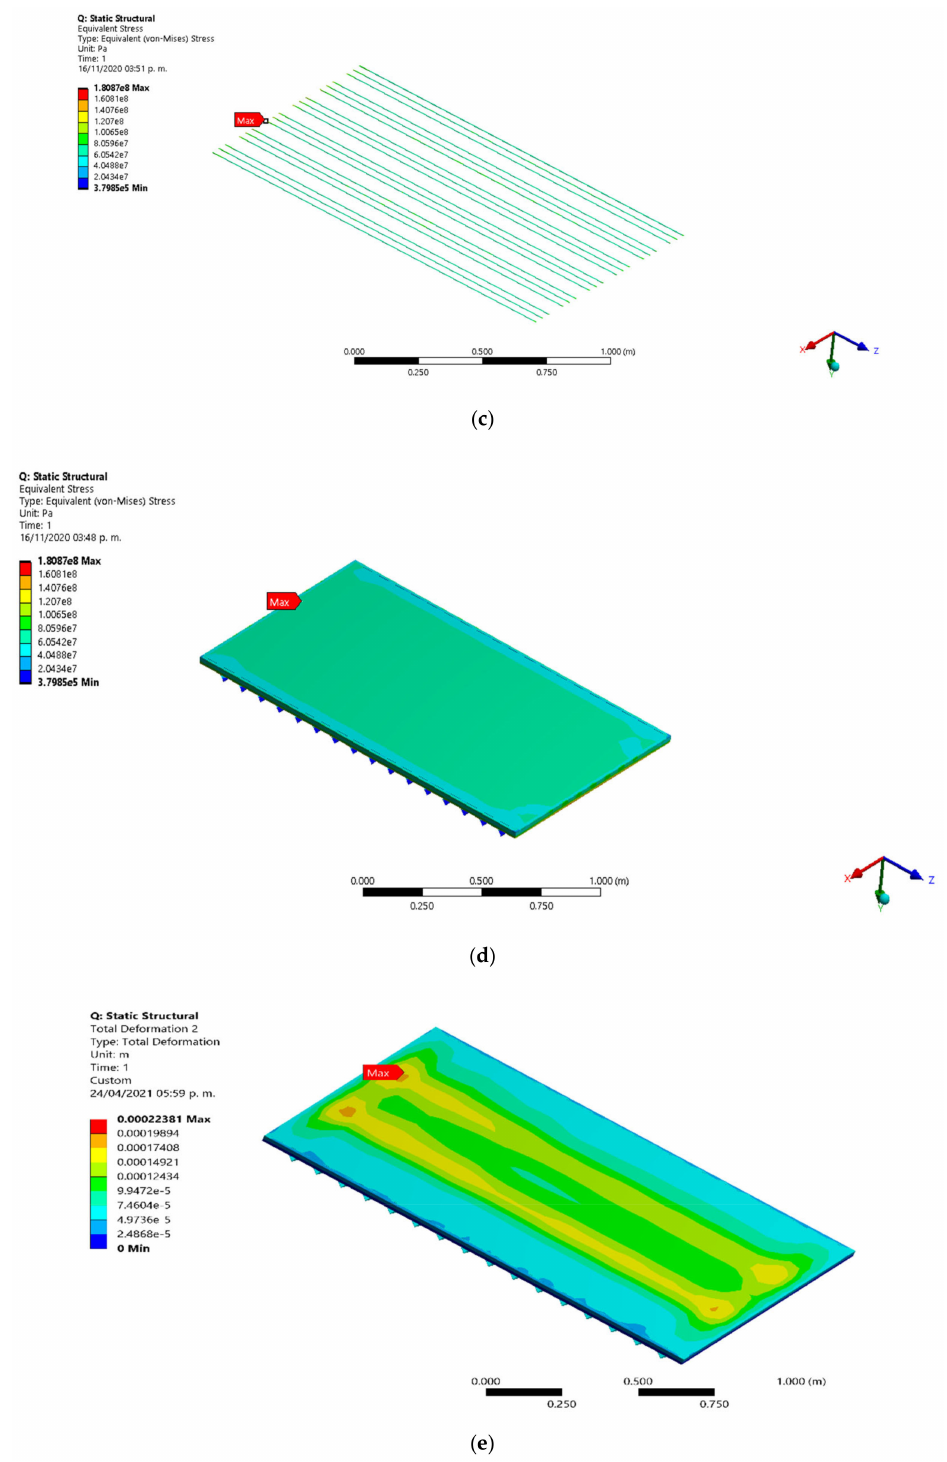
Figure 8. Maximum and minimum stress fields. ( a ) Stress distribution of the whole panel. ( b ) Stress distribution at the electric contact. ( c ) Stress distribution of the whole panel with fins. ( d ) Stress distribution at the electric contact with fins. ( e ) Total deformation at the